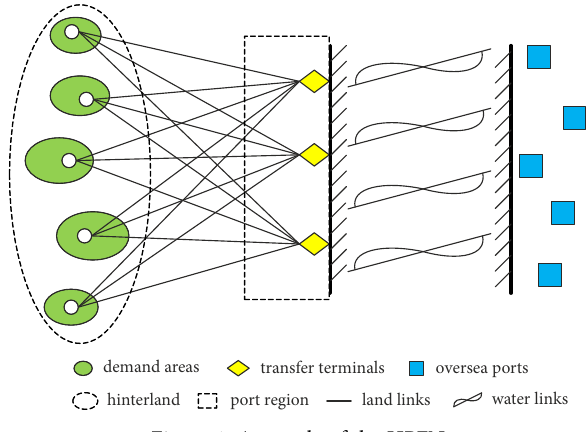
Figure 1. A sample of the